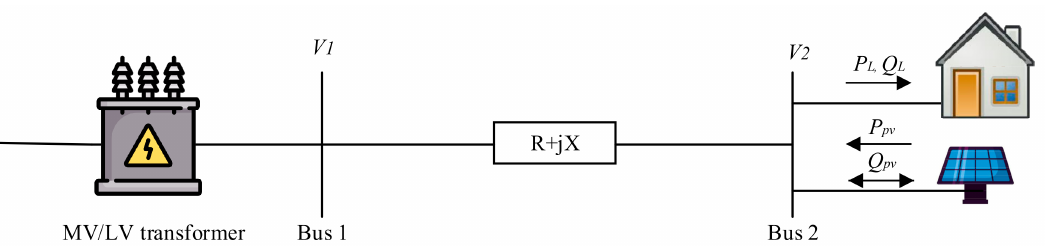
Figure 1. Representation of a simple network